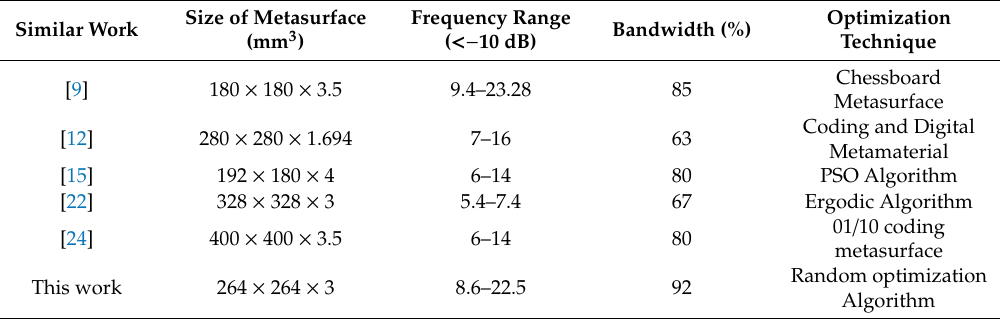
Figure 7. Mono-static radar cross-section (RCS) reduction of a chessboard and coding diffusion metasurface. Table 1. Comparison of the designed metasurface with previously reported works.